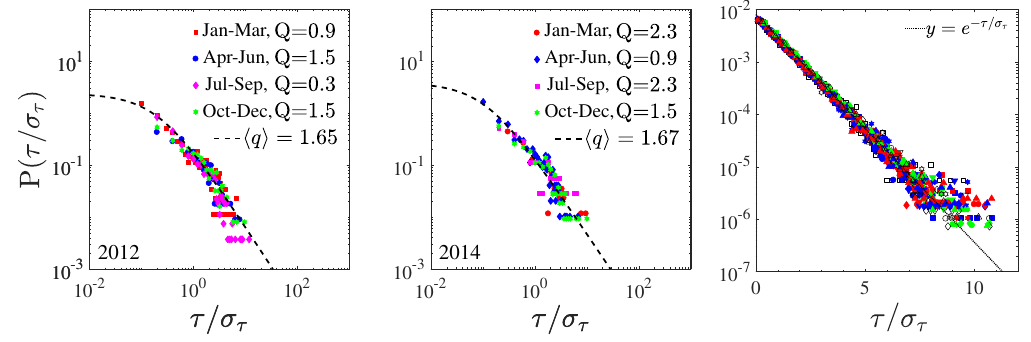
Figure 8. Left panel : Probability density functions (PDFs) of the normalized IOTs P ( τ / σ 0 ) evaluated at different thresholds for different 90-days data sets relative to the year 2012. All the PDFs collapse on to the same theoretical distribution ( dashed lines ). Central panel : same as previous case but for samples relative to the year 2014. Right panel : PDFs of the normalized IOTs P ( τ / σ 0 ) for all 90 data sets obtained after the shuffle procedure (equally spaced bins). The correlation in the Mauna Loa Observatory (MLO) wind dynamics has been completely destroyed by the random permutation of the data. All the IOT sequences converge to an exponential distribution, exposing their uncorrelated